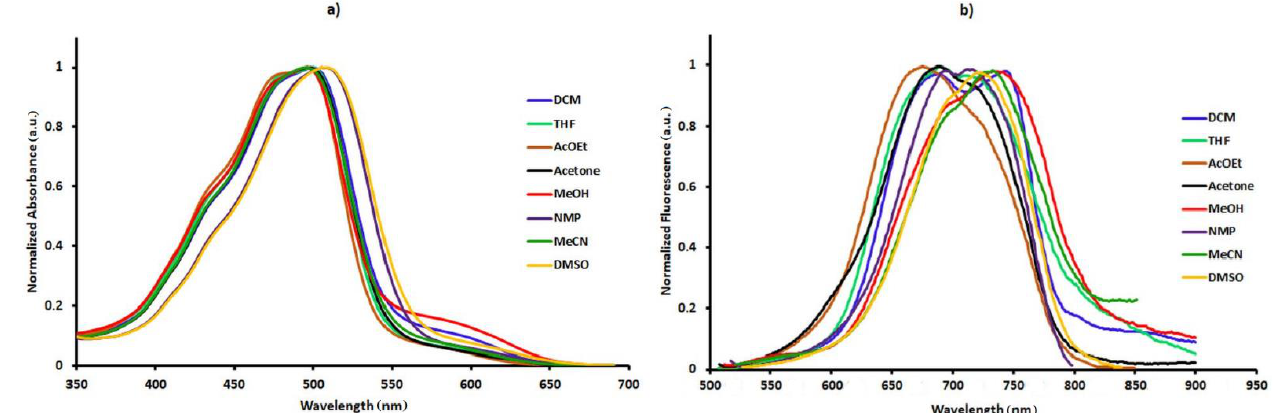
Figure 3. Normalized absorption ( a ) and fluorescence ( b ) spectra of 1-(4-dimethylamino)phenylazonaphthalen-2-ol ( 1 ) in solvents of different polarity.